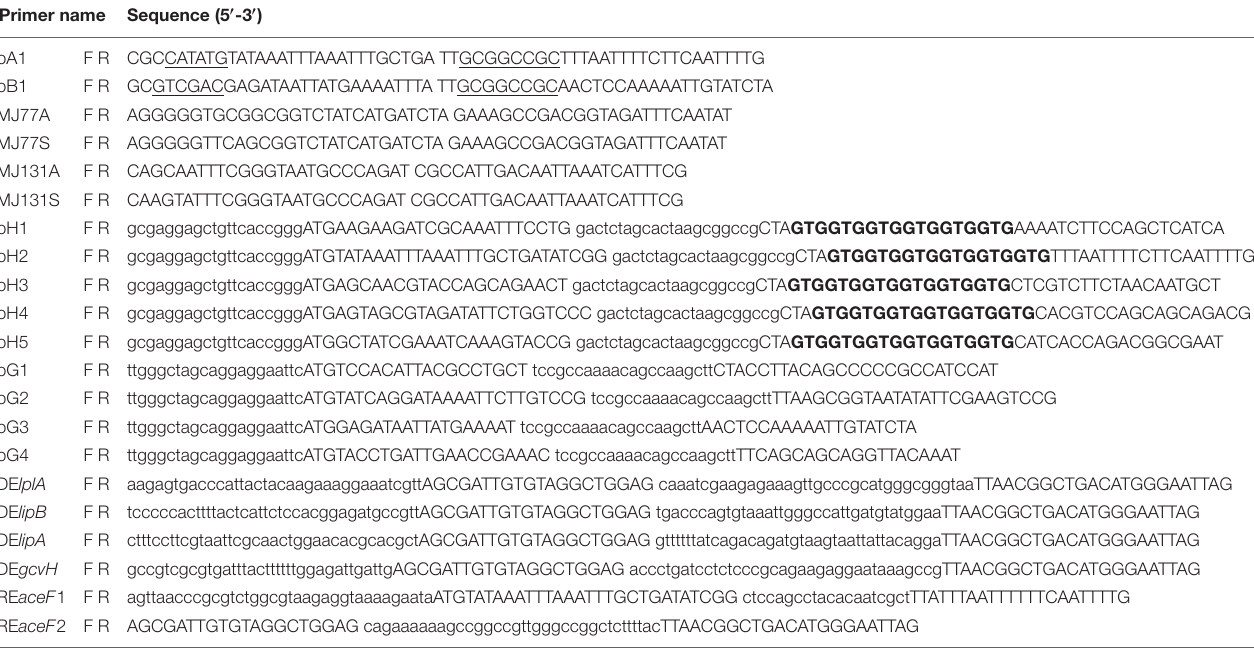
TABLE 2 | Primers used in this